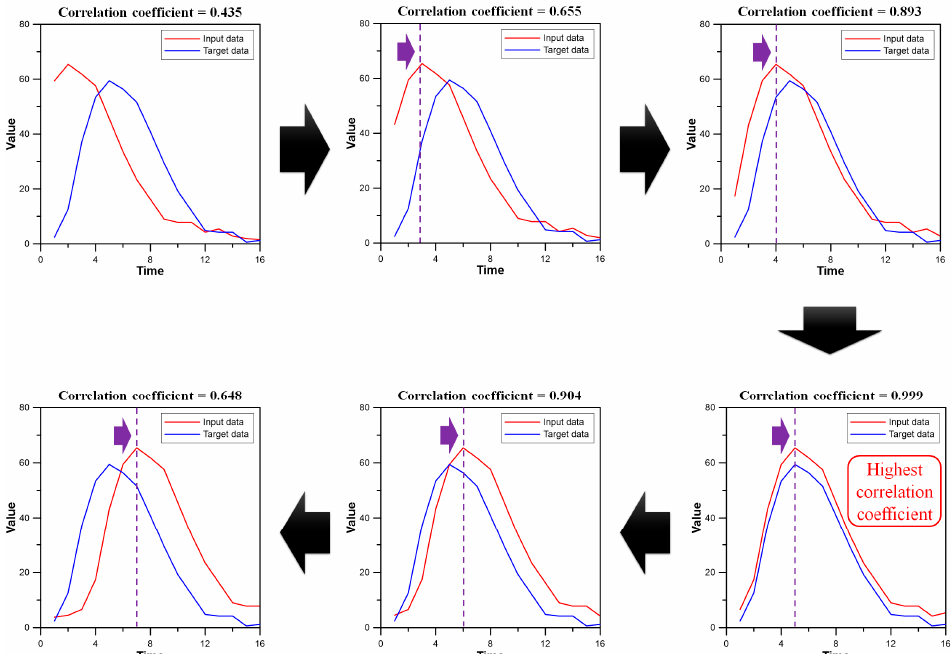
Figure 2. Application of a correlation analysis considering the lag time.